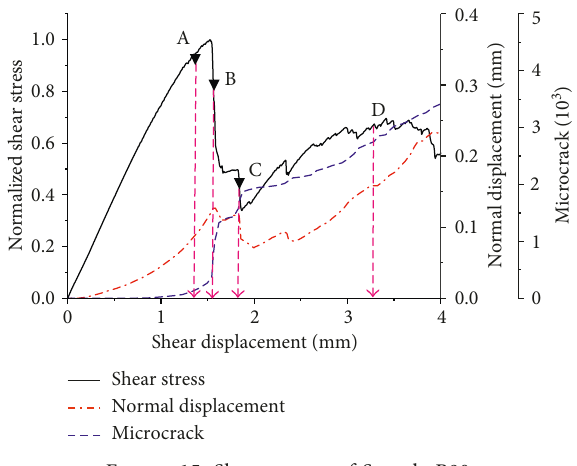
Figure 15: Shear curves of Sample